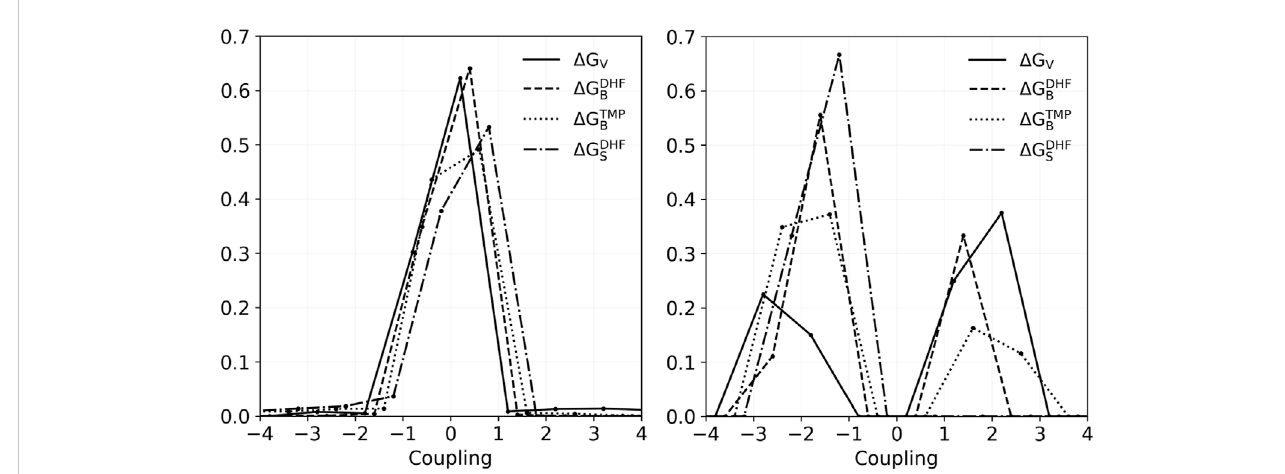
FIGURE 4 Histogramsofcouplingvaluesforvitality,DHFbinding,TMPbinding,andstabilityofthe1149classcombinationsthatoccurredintheredesignof51pairs. Left: All couplings. Right: couplings in the range 1 – 3 kcal/mol.